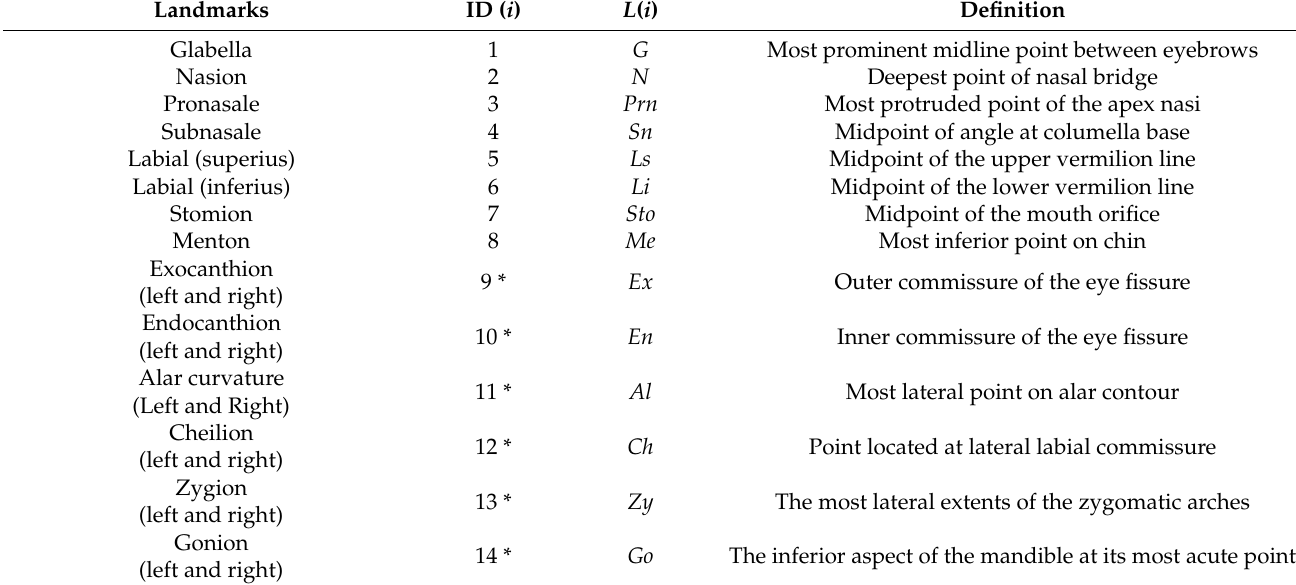
Table 1. Twenty facial landmarks, abbreviations, and